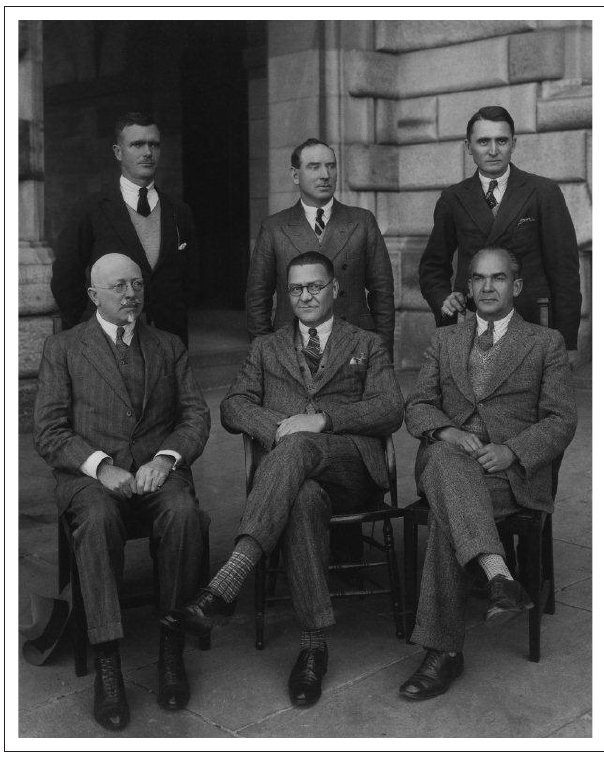
FIGURE 1: First South African Veterinary Board,